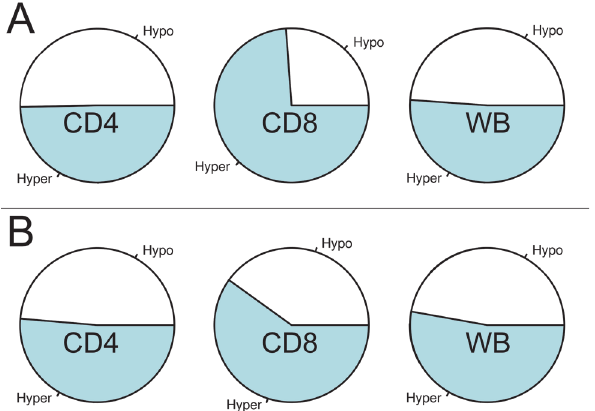
Fig 2. Pie charts of overall methylation levels for the three sample types. A . Pie-charts of DNA hyper- and hypomethylation for all CpG sites with p-values less then or equal to 0.05. B . Pie-charts of DNA hyper- and hypomethylation for all CpG-sites with p-values above 0.05. Abbreviations: Hypo – hypomethylation, Hyper – hypermethylation, CD4 – CD4+ T cell data, CD8 – CD8+ T cell data, WB – whole blood